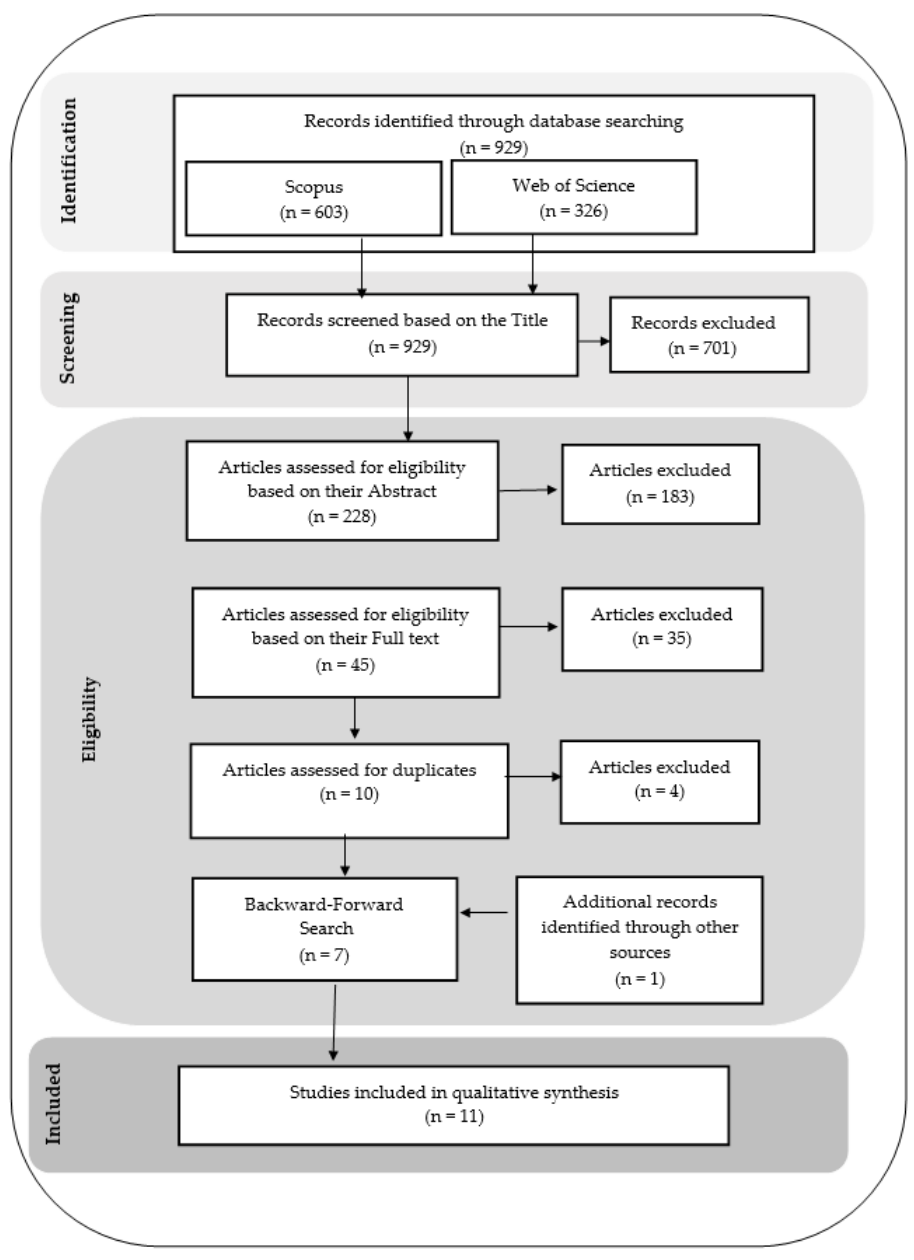
Figure 3. PRISMA Flow diagram [61] of the literature search and articles’ selection for the